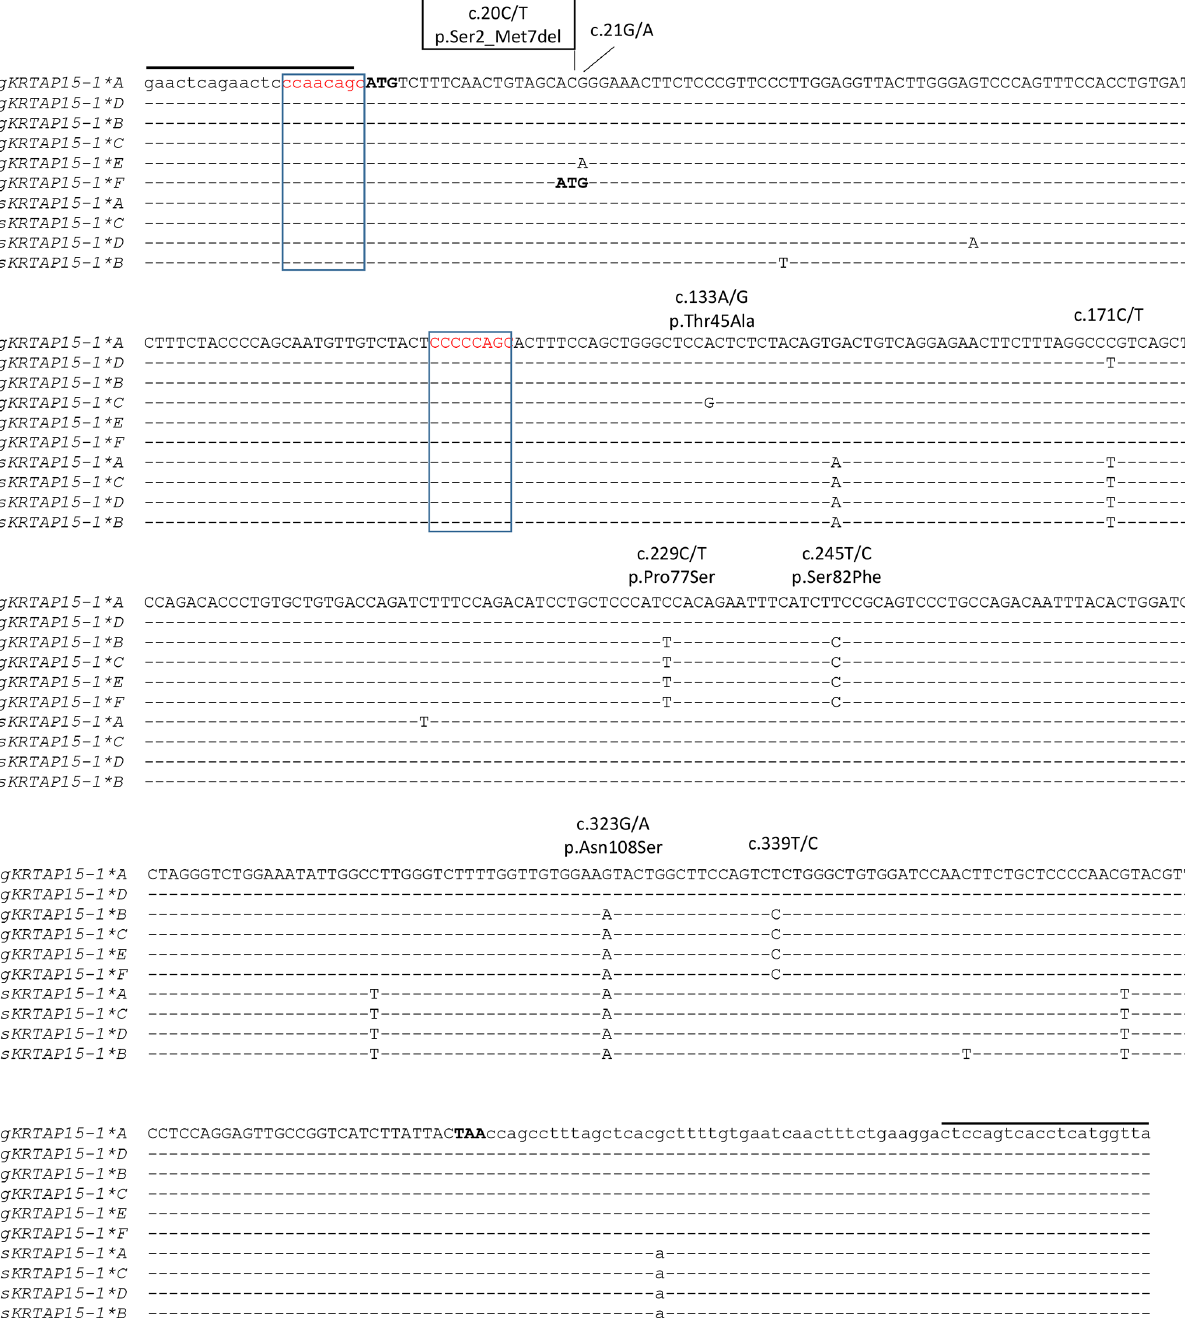
Figure 3. Alignment of the KRTAP15-1 variants identified in goats and sheep. Eight single nucleotide polymorphisms (SNPs) identified in caprine KRTAP15-1 are marked above the sequences, with the non-synonymous SNPs being indicated with the putative amino acid changes and the SNP that would result in an alternative start codon being boxed. Dashes signify homology with the caprine KRTAP15-1*A sequence, with the coding sequence being shown in upper case and the non-coding sequences being shown in lower case. The notional ATG start codon and TAA stop codon are shown in bold. Two putative chi-like sequences are boxed. The primer-binding regions are indicated with horizontal lines. The goat sequences are indicated with a prefix “g”, while the sheep sequences are indicated with a prefix “s”. Numbering of nucleotide and amino acid positions follows the guidelines of the Human Genome Variation Society (HGVS) nomenclature (http://varnomen.hgvs. org/, last access: 21 February 2018). The GenBank accession numbers of these sequences are MH742372 ( sKRTAP15-1*A ),